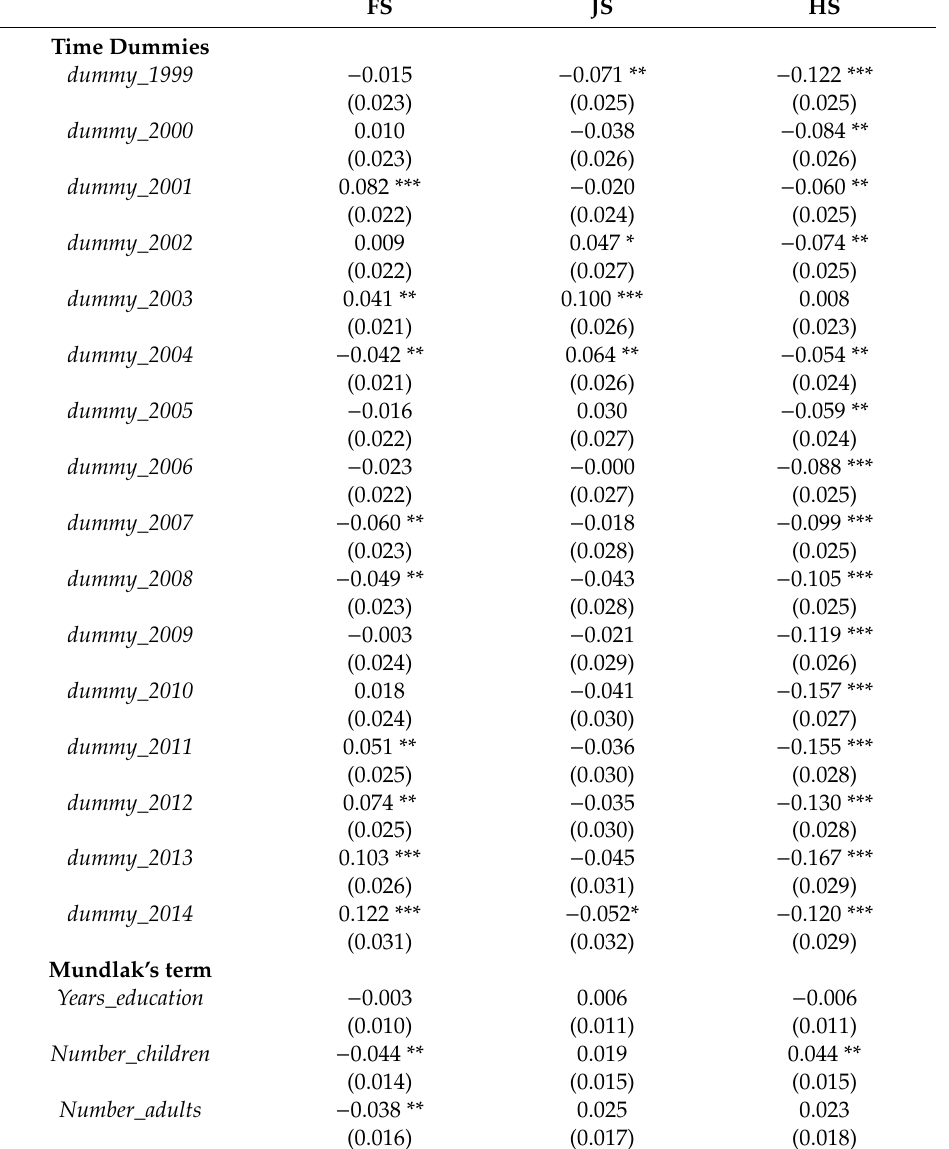
Table A1. Estimation results for domain satisfactions of German citizens, 1998 − 2014 (Time dummies and Mundlak’s